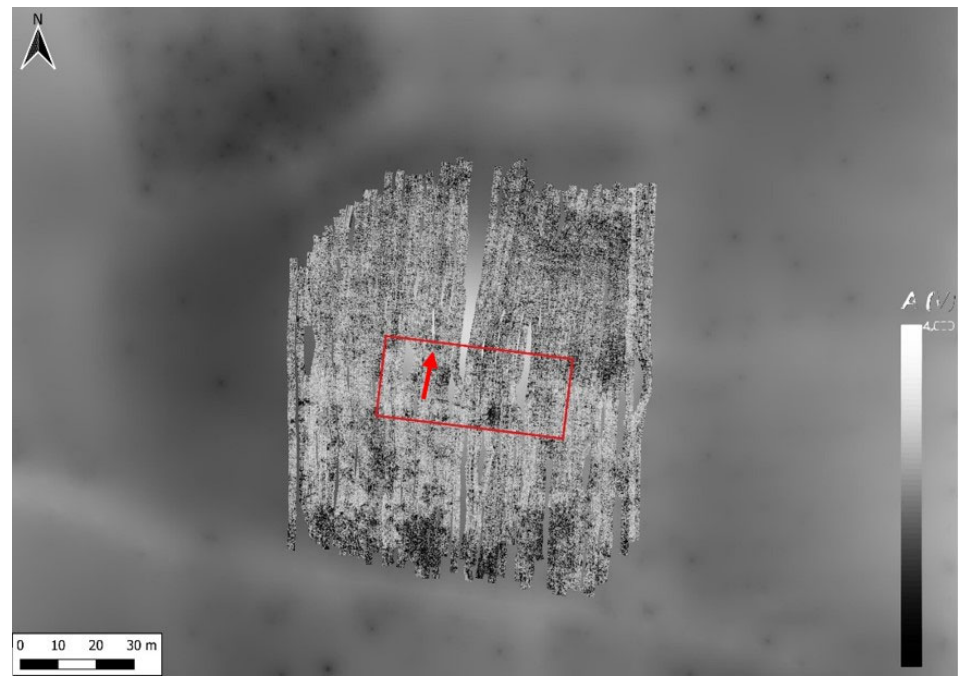
Figure 10. Plan obtained from the processing of data from the MK IV 3D georadar scanner at the same depth as IDS GPR ( − 0.5 m). The black–white scale indicates the resistivity of the localised signals. The red box indicates the highest concentration of disturbance.